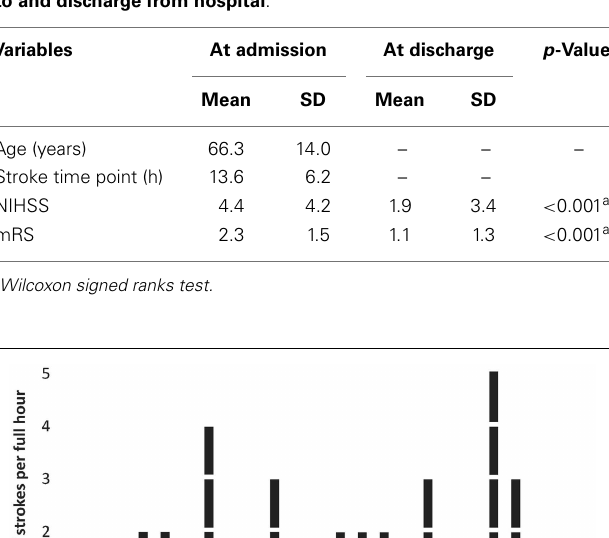
Table 3 | Sleep timing from MCTQ in 35 (13 female) patients before and after stroke .